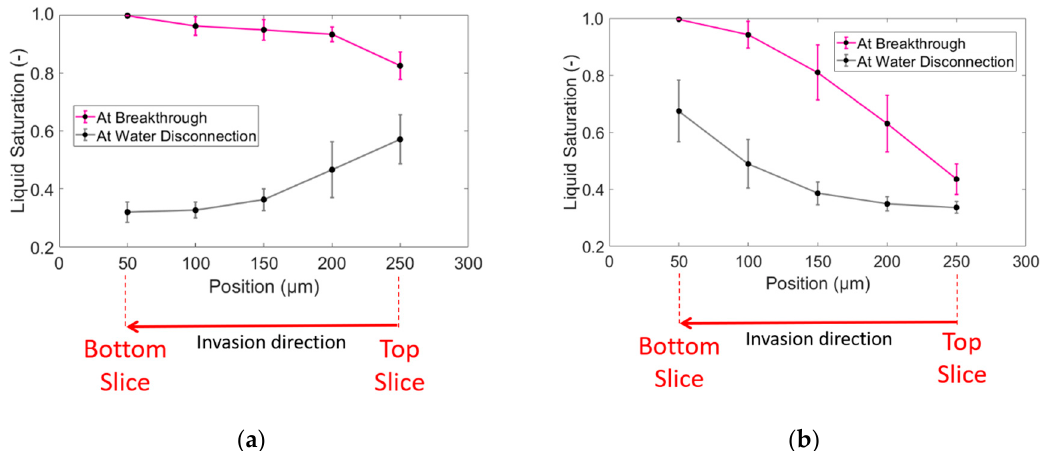
Figure 12. Saturation profiles summarized for ( a ) LTH and ( b ) HTL 3D simulations. The graphs were obtained from Monte Carlo simulation of 15 variations of the pore networks using the simulation parameters summarized in Table 1.